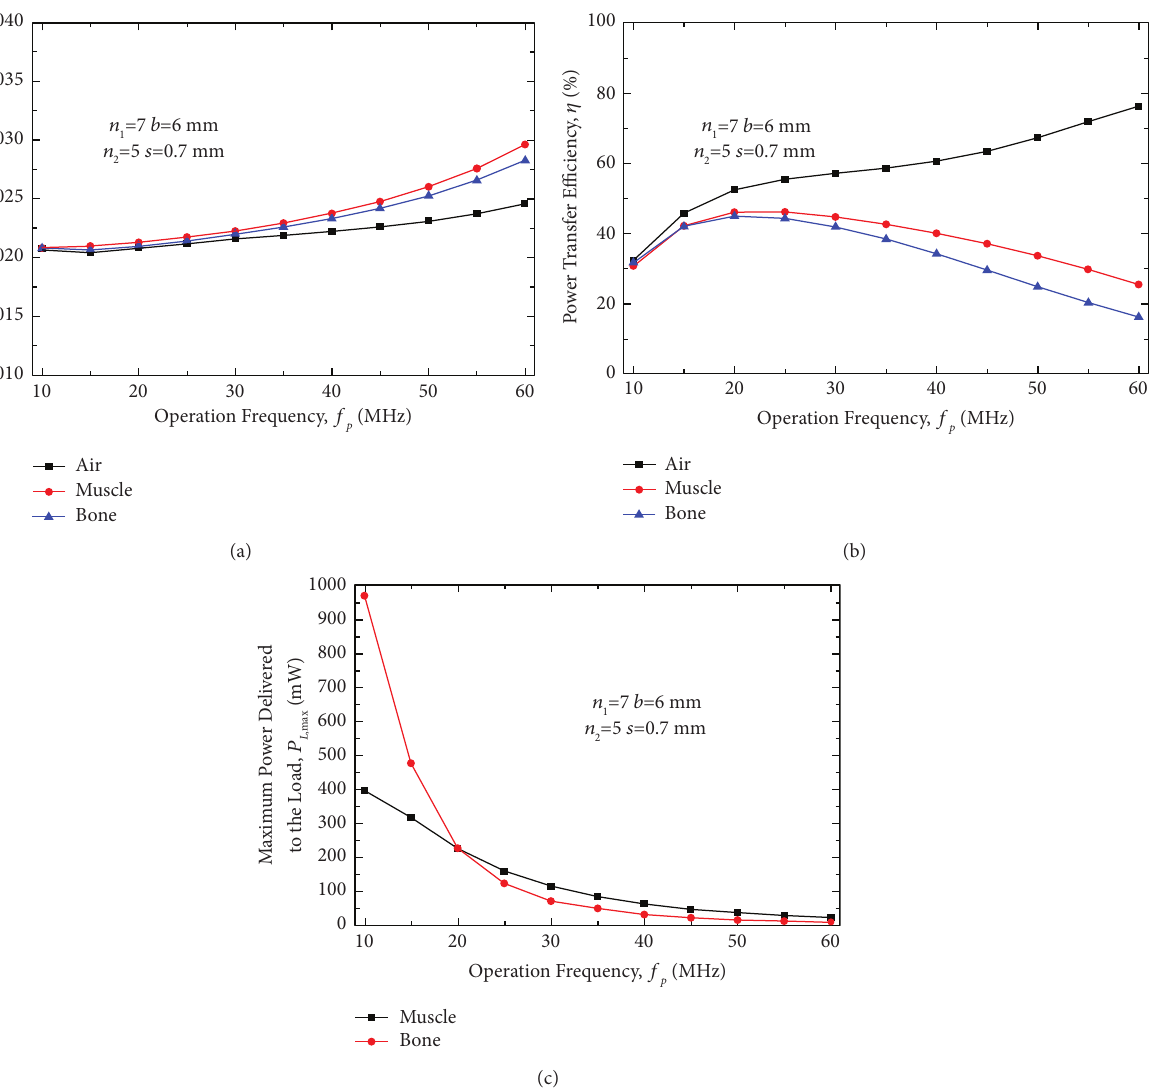
Figure 10: The simulation results of k , PTE, and MPDL of a WPT system in different media: (a) the coupling coefficient, (b) the power transfer efficiency, and (c) the SAR-constrained power delivered to the load. h � 20mm, R av � 20 mm, R 2 � 5mm, r 1 � 0.287mm,